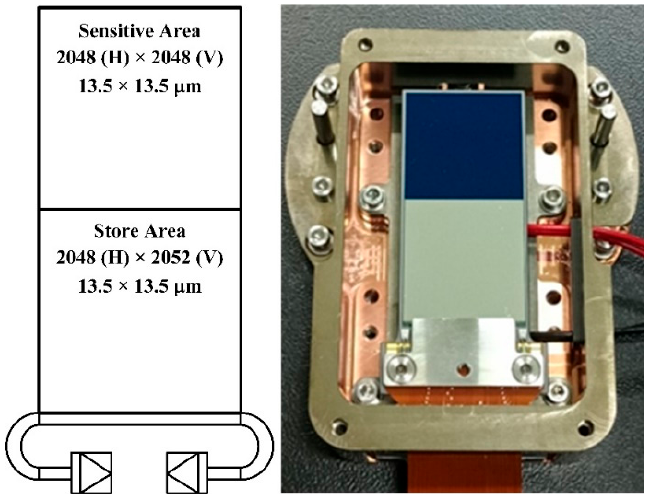
Figure 1. Schematic and physical drawings of E2V CCD42-80.